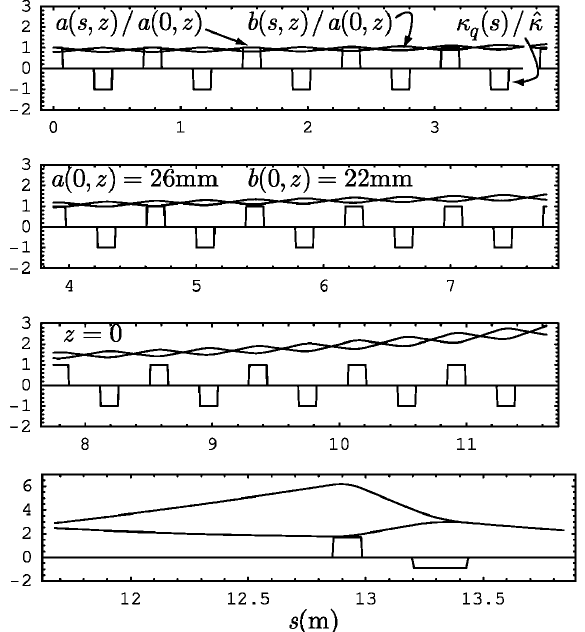
FIG. 7. Envelope dynamics for the slice near the front end of (cid:3) s (cid:5) (cid:2) 0 : 96 . the beam pulse with z=z b